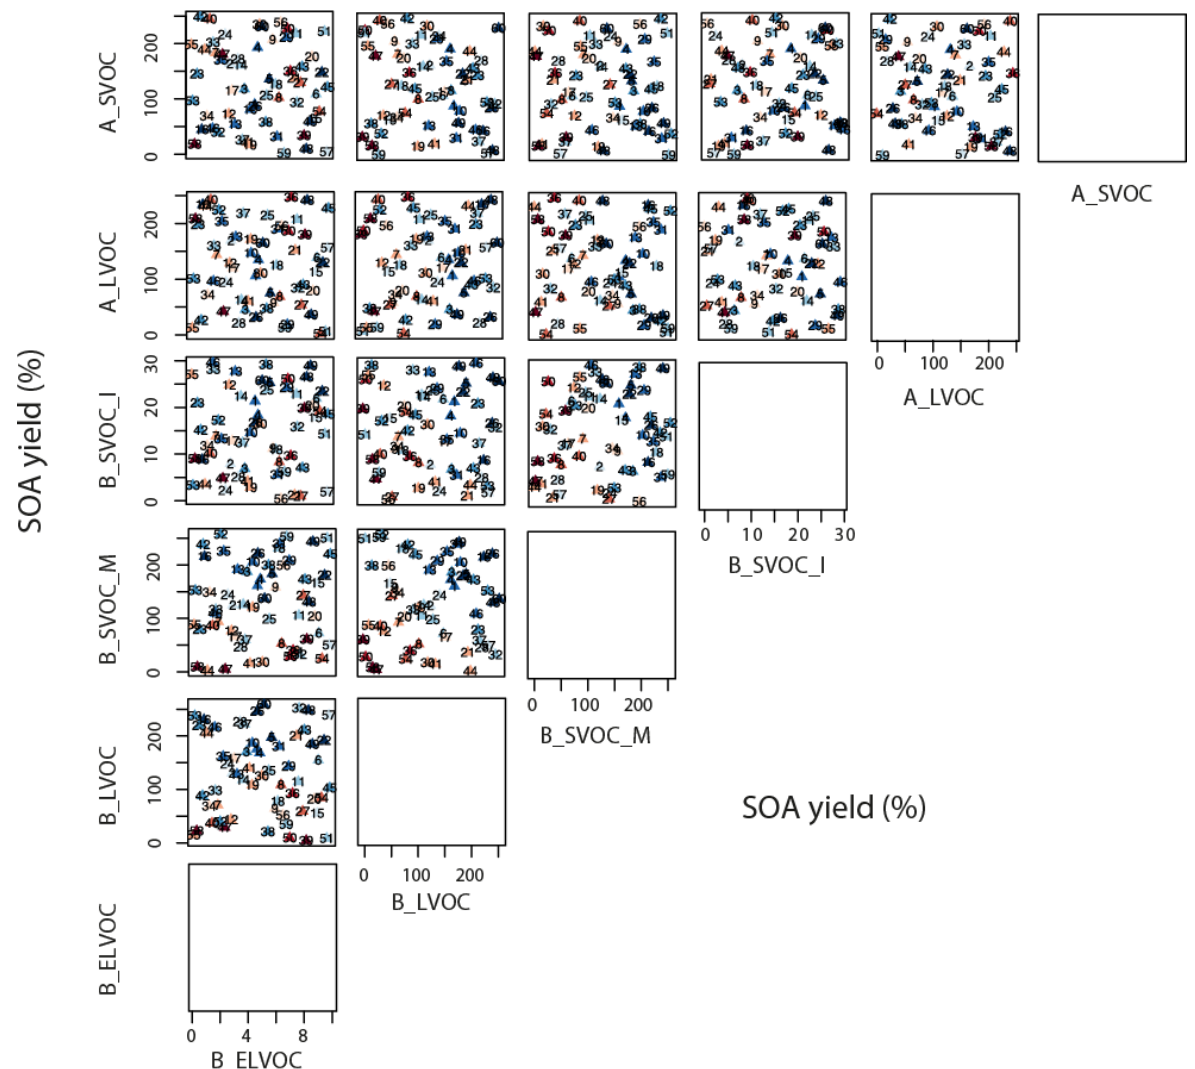
Figure A5. Taylor skill score for model simulations against OA observations across the 6-D parameter space. The x and y axes for a subplot show the total range of reaction yields (in percent) over which of the two parameters (as indicated by the plot labels at the top and right for each subplot respectively) is perturbed in the ensemble. Each triangle in a subplot represents a simulation (labelled 1–60) and the color of the triangle indicates its Taylor skill score for OA. Darker shades of blue indicate low/poor Taylor skill score, and darker shades of red represent high/good Taylor skill score. Note the axis for B_ELVOC shows the scaling factor for B_ELVOC yields. Axes for the rest show the corresponding ox-VOC